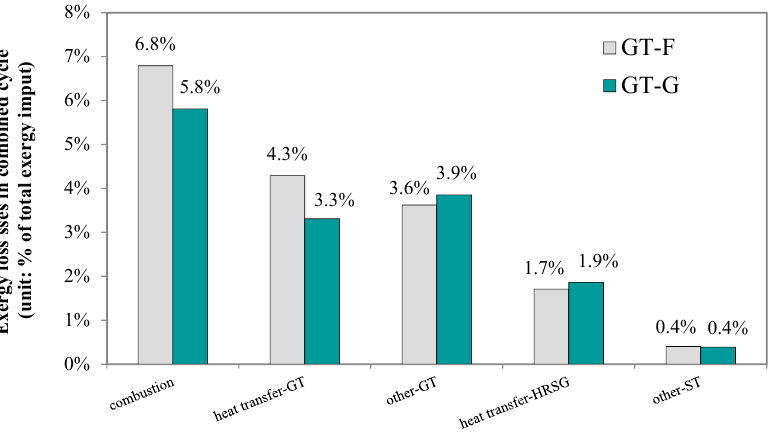
Figure 11. Effect of gas turbine choices on exergy losses of polygeneration systems.